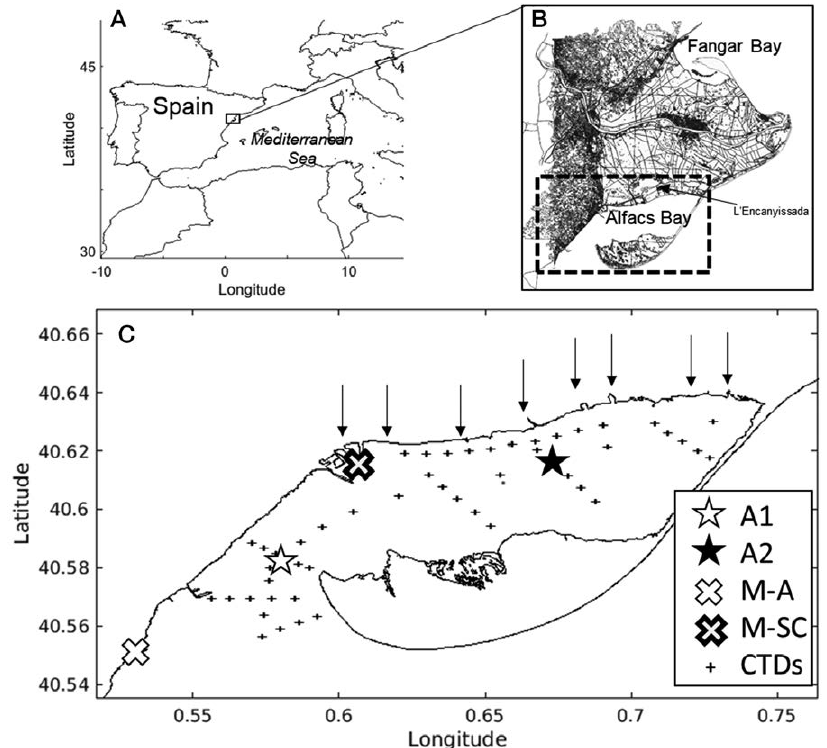
Fig 1. – Alfacs Bay, measurement locations and numerical domain (dashed line in B). The stars indicate the mooring location, the x-symbol specifies the meteorological land-based stations, and the crosses the CTD profiles. The arrows indicate the freshwater discharges from the rice fields used in the numerical